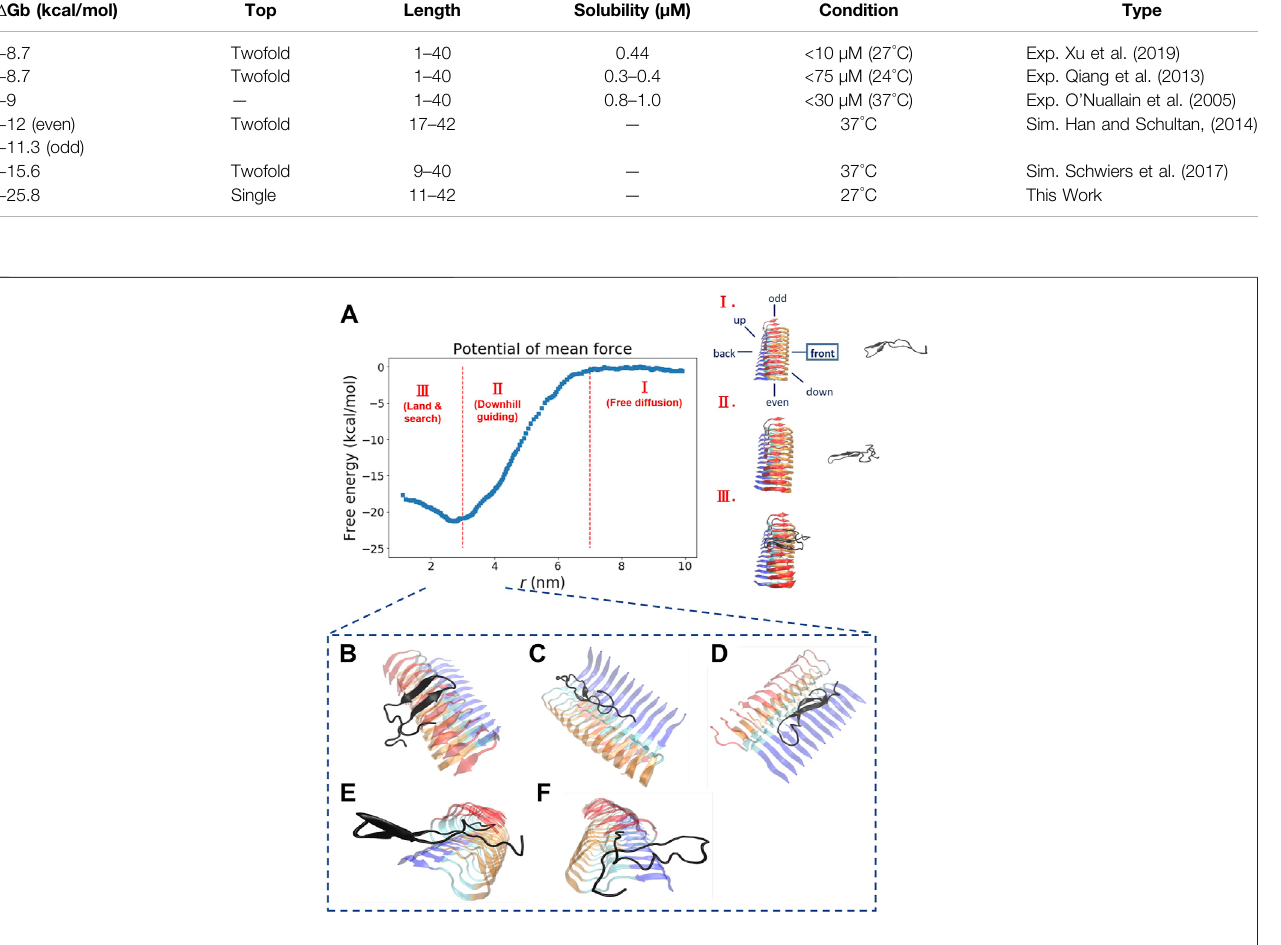
FIGURE2| The free energy pro fi le for a single Abeta11-42 monomer binding to the Abeta42 fi brillar surface (12 chains) is shown. (A) The free energy pro fi le features three different aggregation stages, labeled as I. Free diffusion. II. Downhill guiding. III. Dock and lock. r is de fi ned as the distance between the C-beta of residue 27th in the free monomer and the C-beta of residue 27th of chain F in the fi bril. A representative con fi guration at each aggregation stage is schematically shown on the right. Simulations were prepared with six different monomer positions with respect to the central pre-existing fi bril. Six orientations: front, back, up, down, even, odd areschematicallyshown in the diagram. The free energy pro fi leshown refers to the result obtained from thesimulation setup with the monomer positioned in the “ front ” orientation. The free energy pro fi les for the rest of the orientations are shown in the Supporting Information (Supplementary Figure S2). (B – F) The representative structures taken from stage III in which different binding con fi gurations are formed upon the monomer landing and searching over the fi brillar surface. These binding con fi gurations are potentially surface-catalyzed precursors for fi bril growth. (B) C-ter surface precursor (C)